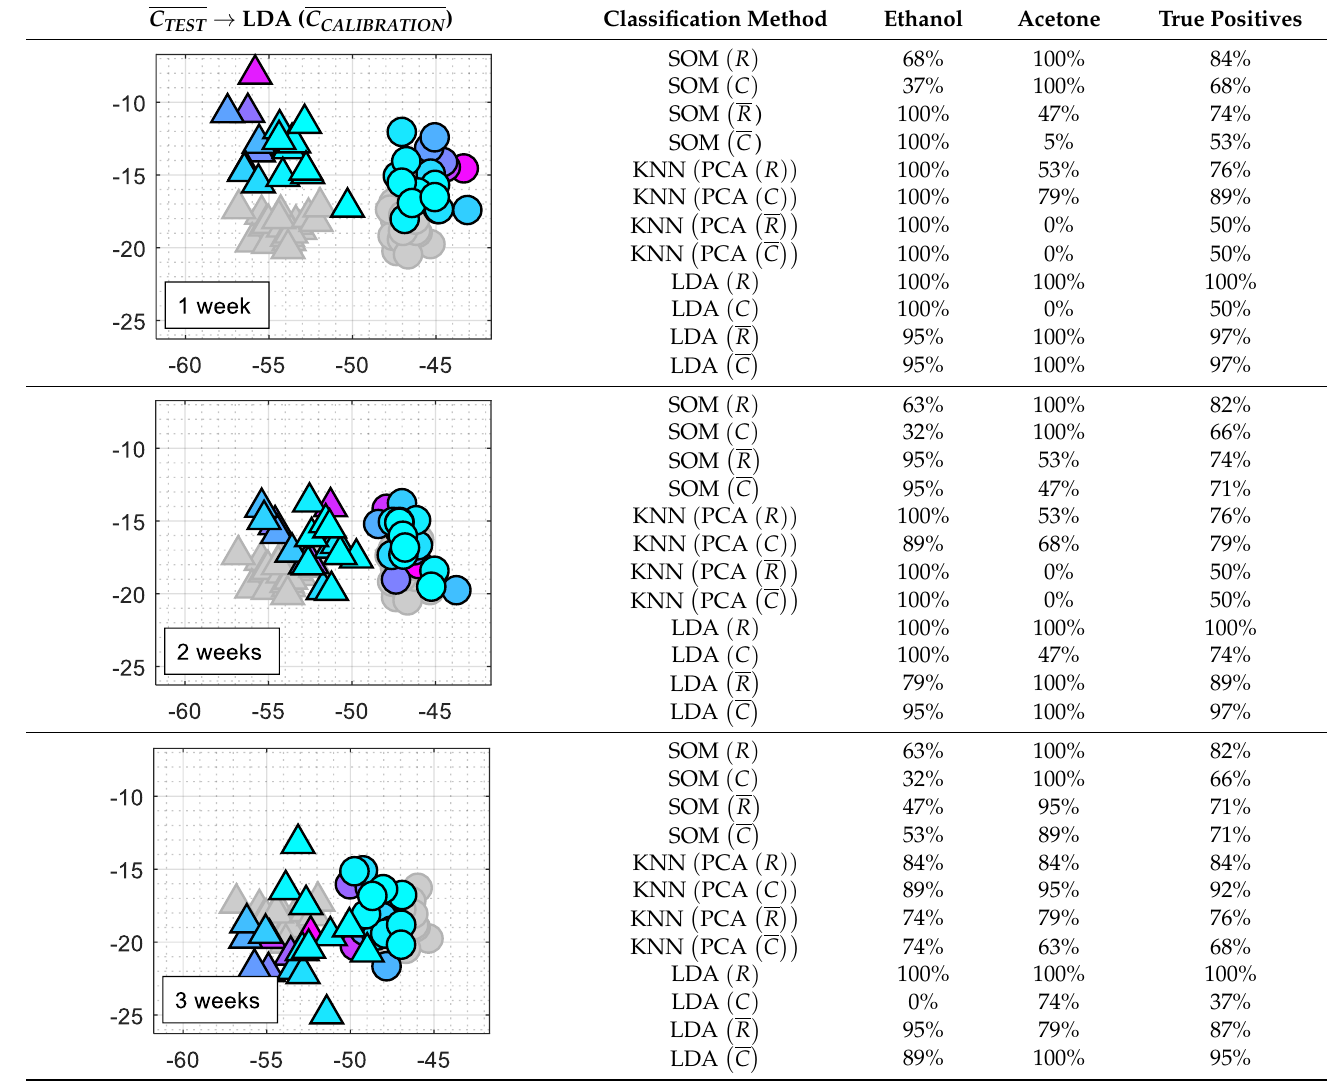
Table 4. Classification results obtained with the different classification methods assessed: comparative projection of the test data into the space defined by the two principal components obtained during the LDA analysis of the calibration data C CALIBRATION , classification methods assessed, samples correctly classified as ethanol (triangle) and acetone (circle), and average true